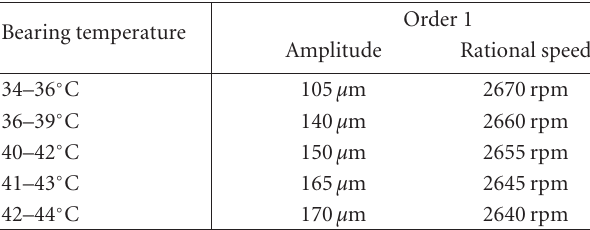
Table 2: Amplitudes and critical speeds at the bearing support B1 for